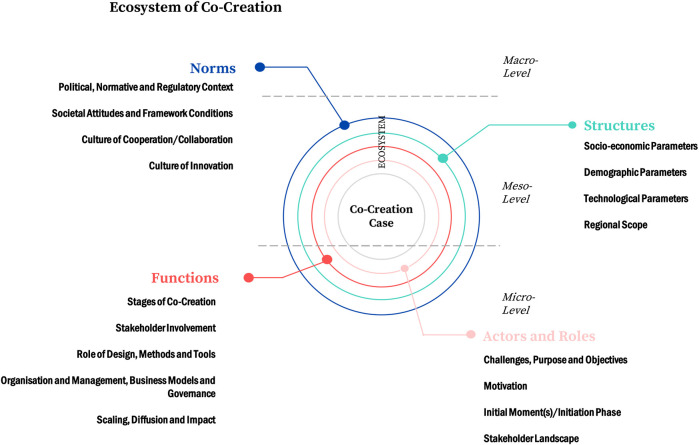
Ecosystem of Co-Creation (Source: own; based on Kaletka et al., 2017).